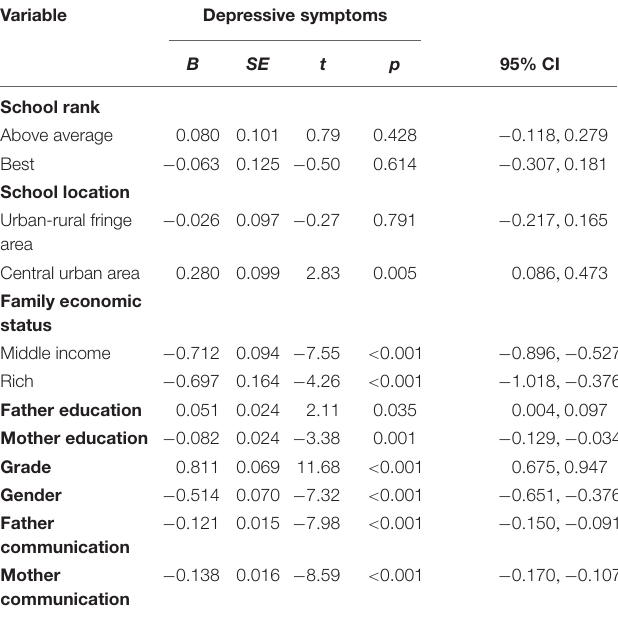
between father-adolescent communication and adolescents’ depressive symptoms.